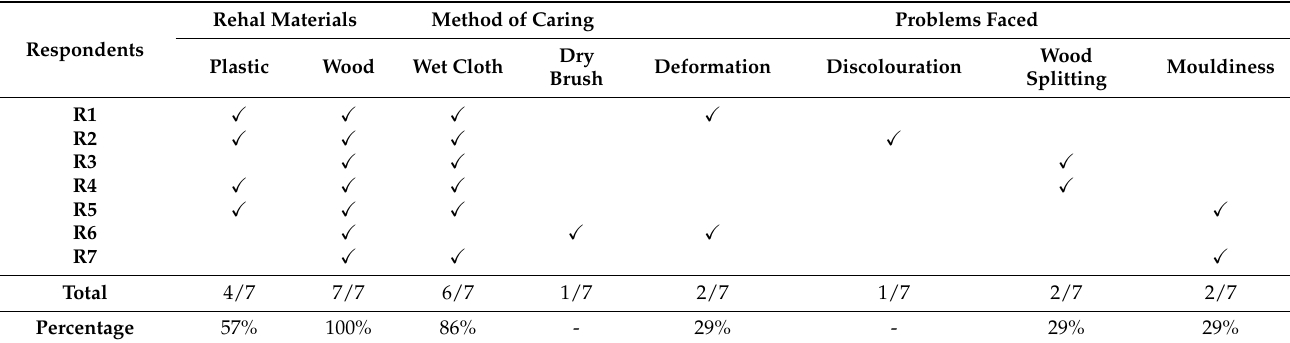
Figure 4. Atlas-ti network of rehal materials. Table 2. Analysis of interview content of Question 1.